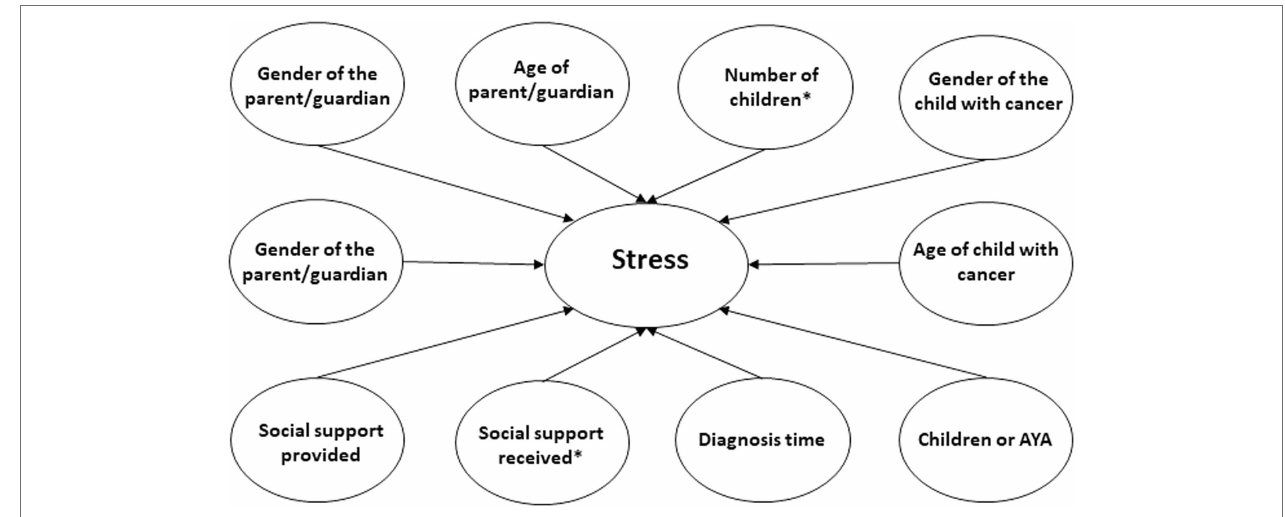
FIGURE 1 | Stress